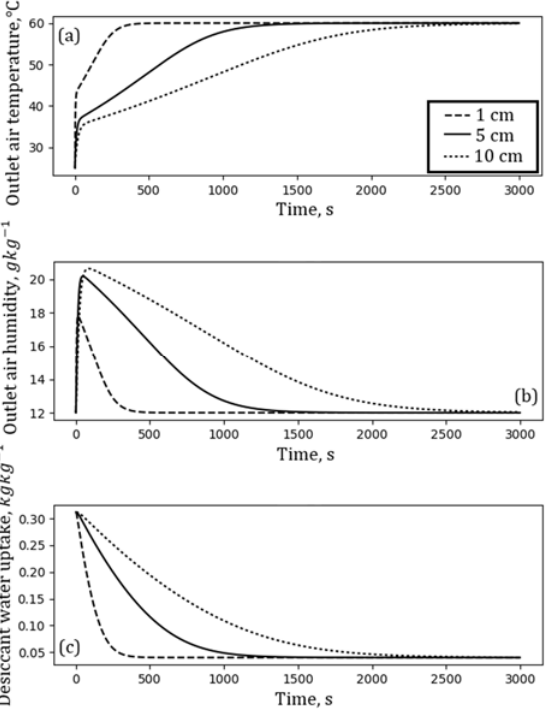
Figure 13. The influence of desiccant filling height on desorption characteristics: ( a ) Outlet air temperature; ( b ) Outlet air humidity; and ( c ) Desiccant water uptake.